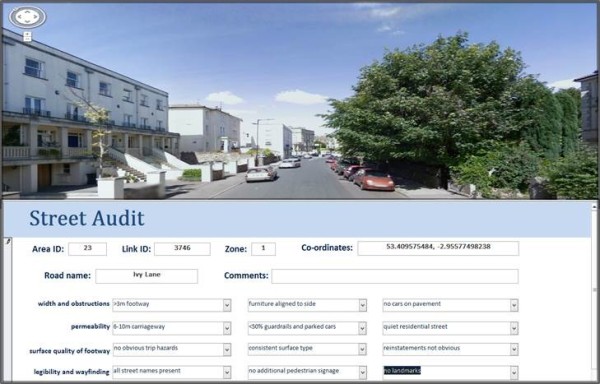
FASTVIEW audit tool.